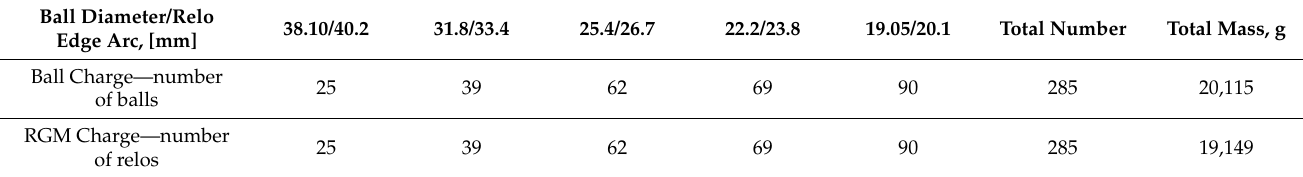
Table 2. Bond mill test media charge—5% greater surface